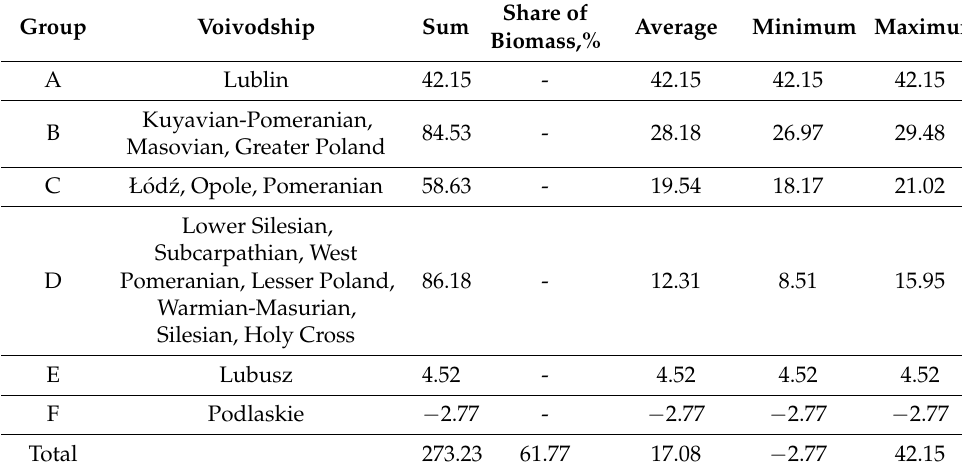
Table 2. Energy potential by clusters (crop residues and manure biogas), PJ (2018).